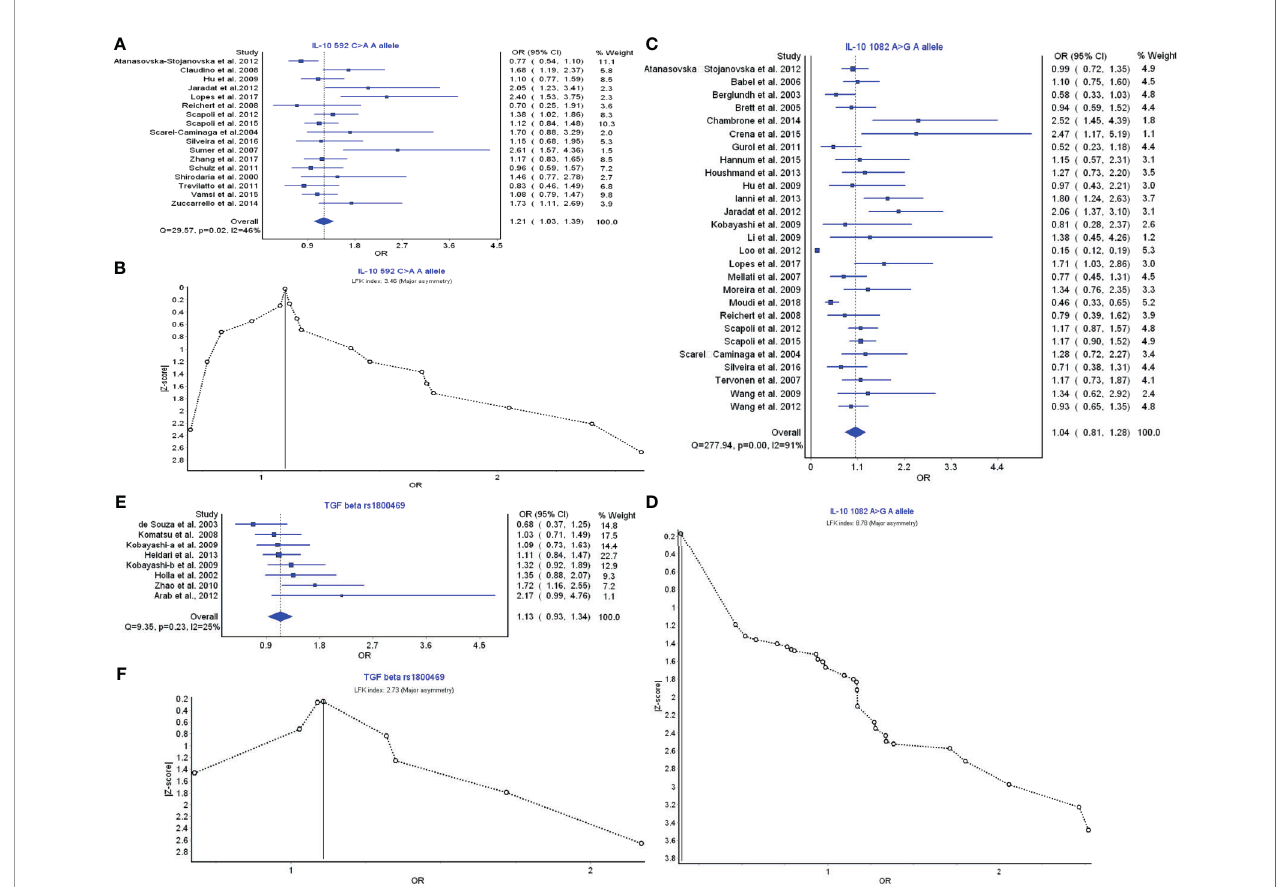
FIGURE 5 | The association of Treg-related cytokine polymorphism with chronic periodontitis. (A) Forest plot of the association of IL-10 592C>A A allele polymorphism with chronic periodontitis. (B) The Doi plot is used to visualize the asymmetry of the association of IL-10 592C>A A allele polymorphism with chronic periodontitis using the LFK index. LFK index zero represents complete symmetry, the limits of symmetry were set at ±1, and values beyond ±1 were inconsistent with symmetry. (C) Forest plot of the association of IL-10 1082A>G A allele polymorphism with chronic periodontitis. (D) The Doi plot is used to visualize the asymmetry of the association of IL-10 1082A>G A allele polymorphism with chronic periodontitis using the LFK index. (E) Forest plot of the association of TGF- b rs1800469 polymorphism with chronic periodontitis. (F) The Doi plot is used to visualize the asymmetry of the association of TGF- b rs1800469 polymorphism with chronic periodontitis using the LFK index. LFK index zero represents complete symmetry, the limits of symmetry were set at ±1, and values beyond ±1 were inconsistent with